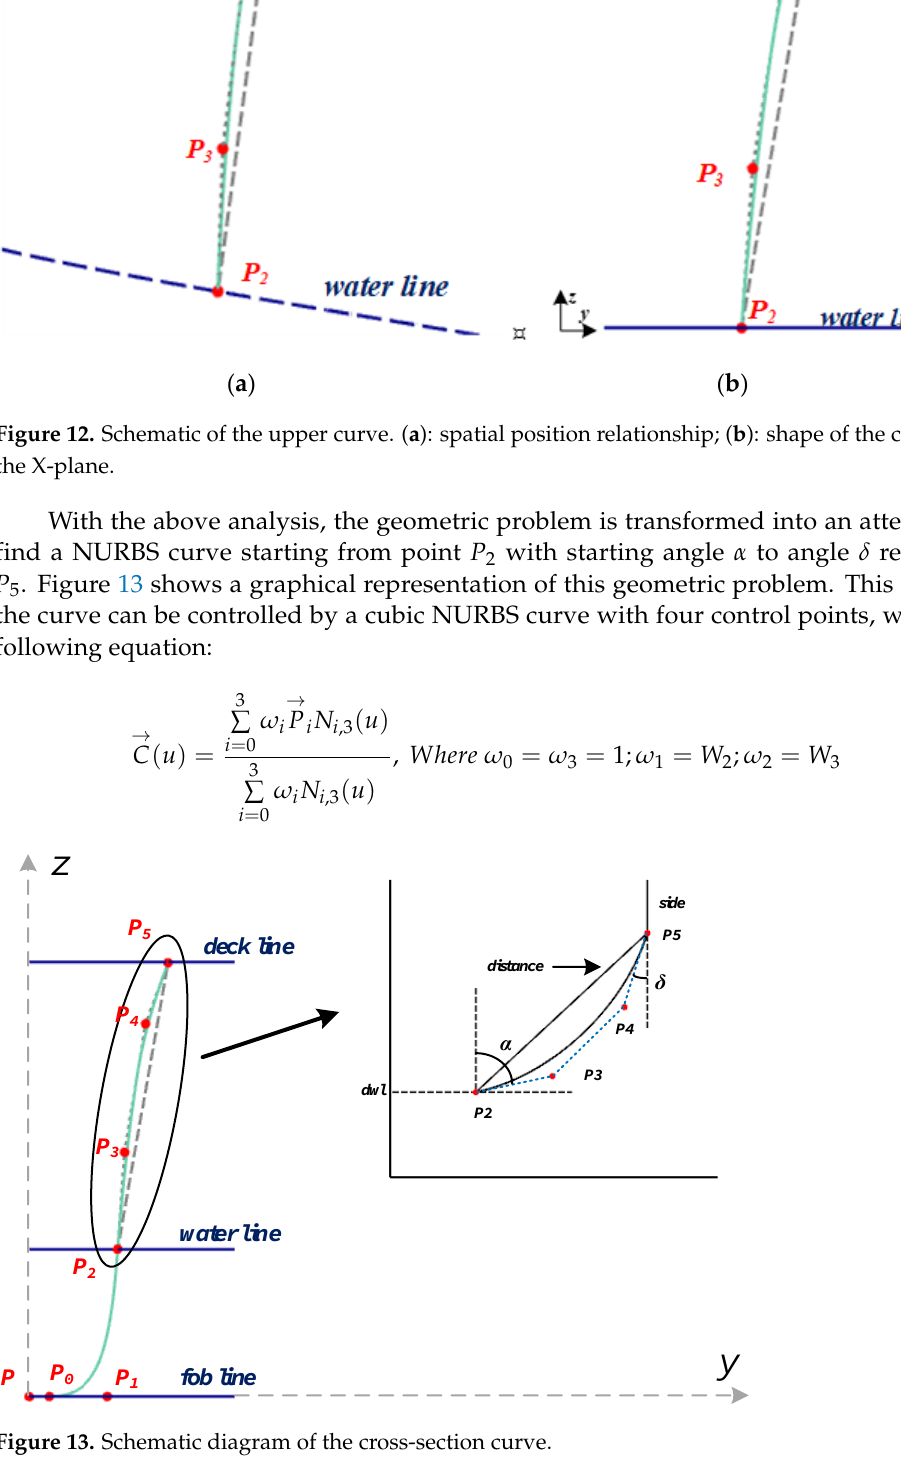
w =1 . 5 Figure 11. Changing curve shape by changing weighting factor. (3) Definition of the upper curve The last part is the curve between the waterline and the deck line. The lower end of this part of the curve is at the point P 2 (YP 2 ,ZP 2 ) , which is connected to the quadratic